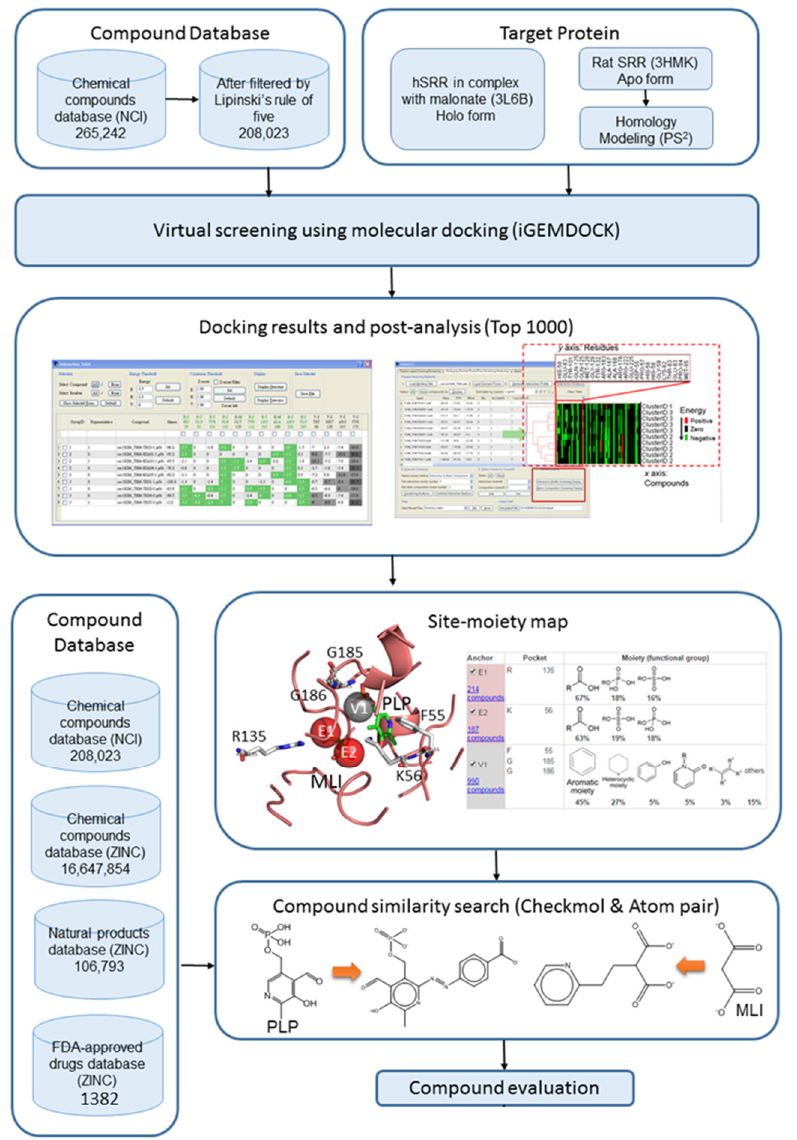
Figure 2. The work flow chart of this